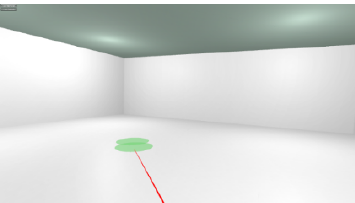
Figure 2. Using controllers to teleport to the target